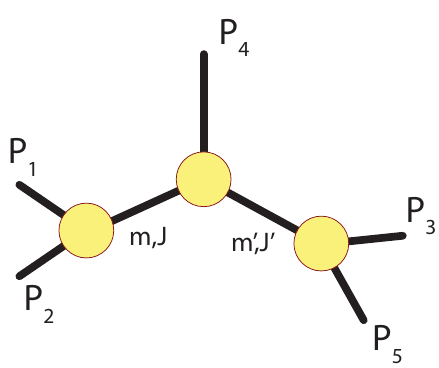
Figure 11. A (cid:12)ve-point scattering amplitude can also be decomposed by inserting a complete basis of states labeled by the mass of the intermediate particles and their